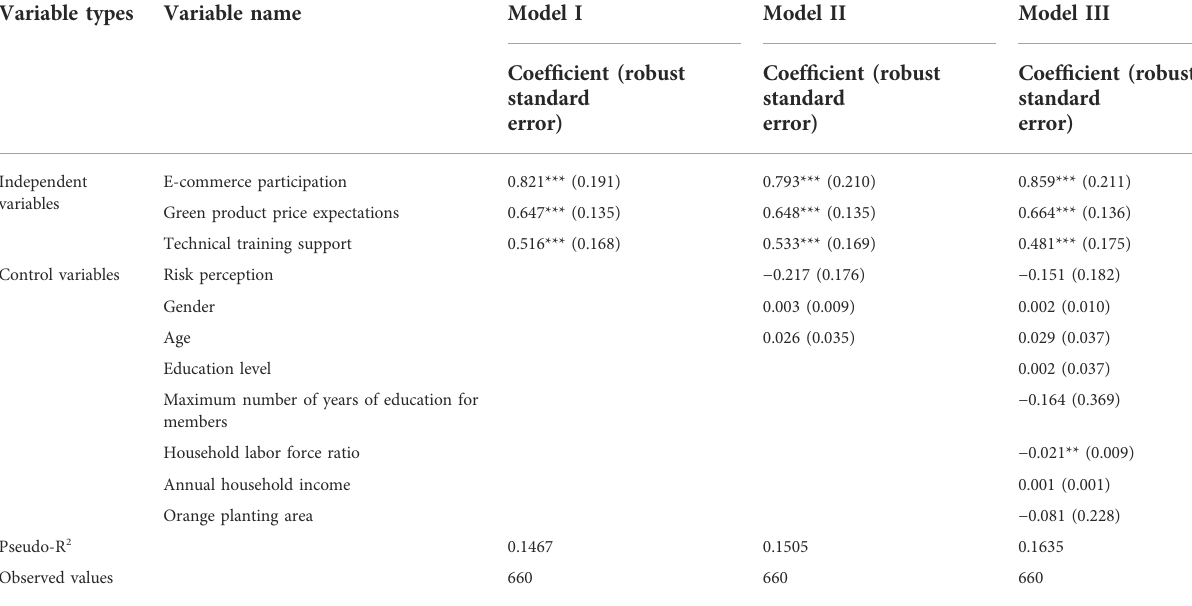
TABLE 4 Regression results of the impact of green farming technology adoption among resettled orange growers. Variable